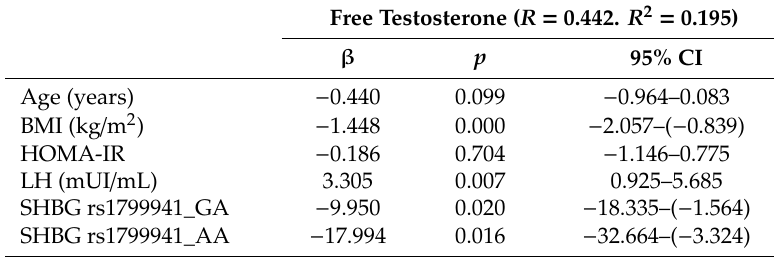
Table 3. Lineal regression analysis with FT as dependent variable, and age, BMI, HOMA-IR, LH and the polymorphism variants of the SHBG rs1799941 as independent parameters.